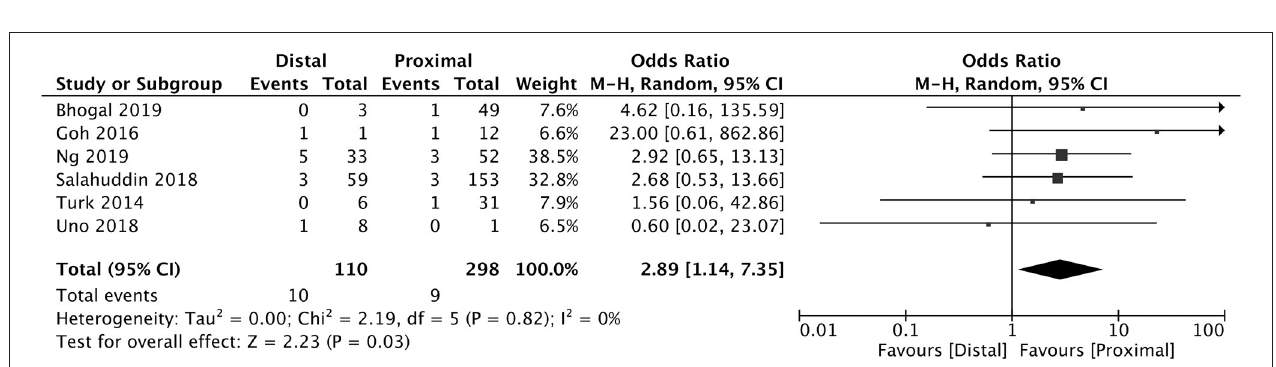
with the sharp curves the MCA takes as it courses over the insula and operculum predispose the vessel to endothelial injury as well as neighboring arterioles and venules to higher tensile forces and possible rupture (38). Distal positioning is also more challenging to achieve having to navigate more branching points and vessel tortuosity, often without roadmap guidance, contributing to a higher risk of vessel perforation and subsequent